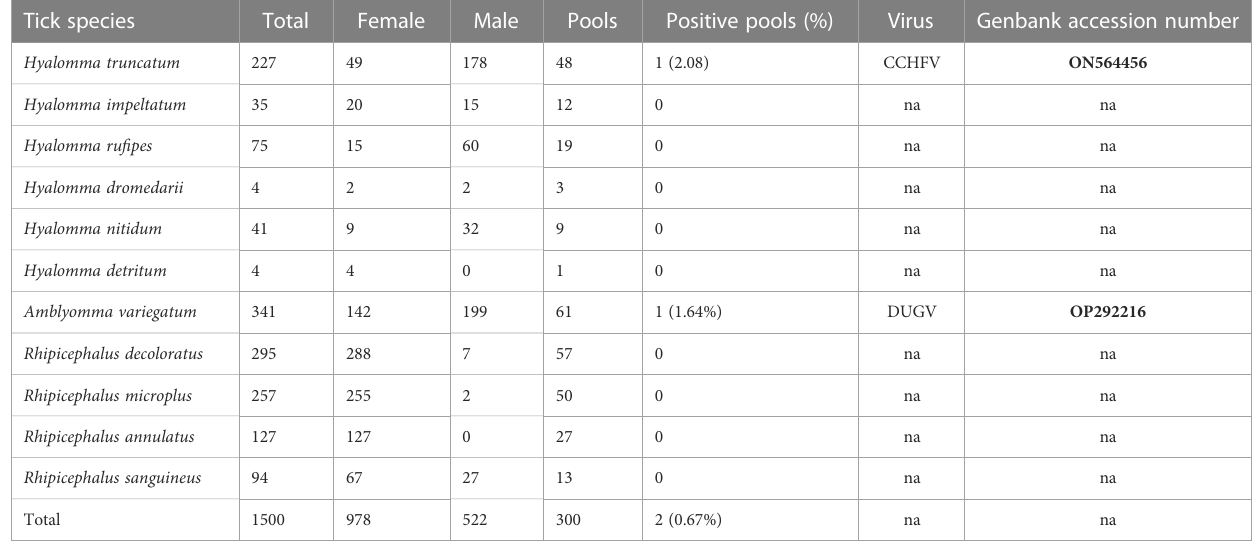
TABLE 2 Checklist of the tick species screened for orthonairoviruses and the infection rates detected. Tick species Total Female Male Pools Positive pools (%) Virus Genbank accession